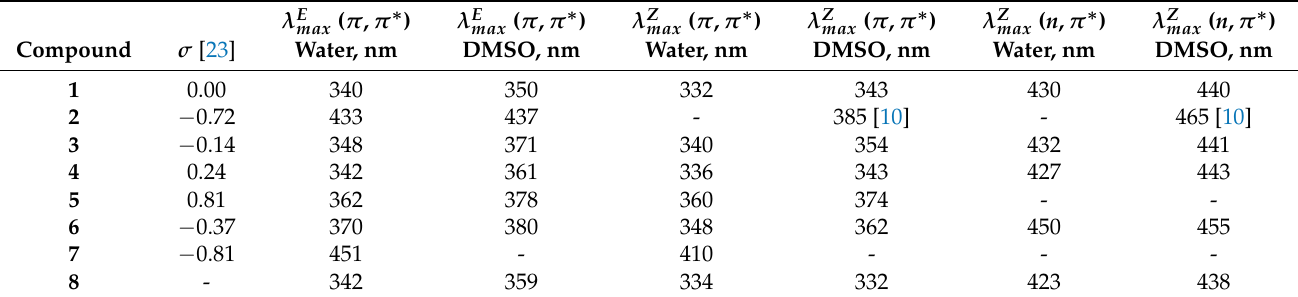
Figure 3. Dark-adapted and light-adapted spectra of investigated ATPLs in water. Transient ab- sorption UV-Vis spectra are shown in the insets. Spectral bands are related to E , Z isomers and ( π , π ∗ ), ( n , π ∗ ) transitions. * For compounds 2 and 7 the band can be decomposed into two Gaussian functions (see Supplementary Materials for details). Table 1. Absorption band maxima of ATPLs considered in the current study. For compounds 2 and 6 in DMSO and compounds 2 and 7 in water the absorption band was decomposed into two Gaussian functions (see Supplementary Materials for details). σ is the Hammett constant of substituents. λ E max ( π , π ∗ ) and λ Z max ( π , π ∗ ) are the absorption band maxima of the ( π , π ∗ ) transition of the E and Z isomers, respectively. λ Z max ( n , π ∗ ) is the absorption band maximum for the ( n , π ∗ ) transition of the Z